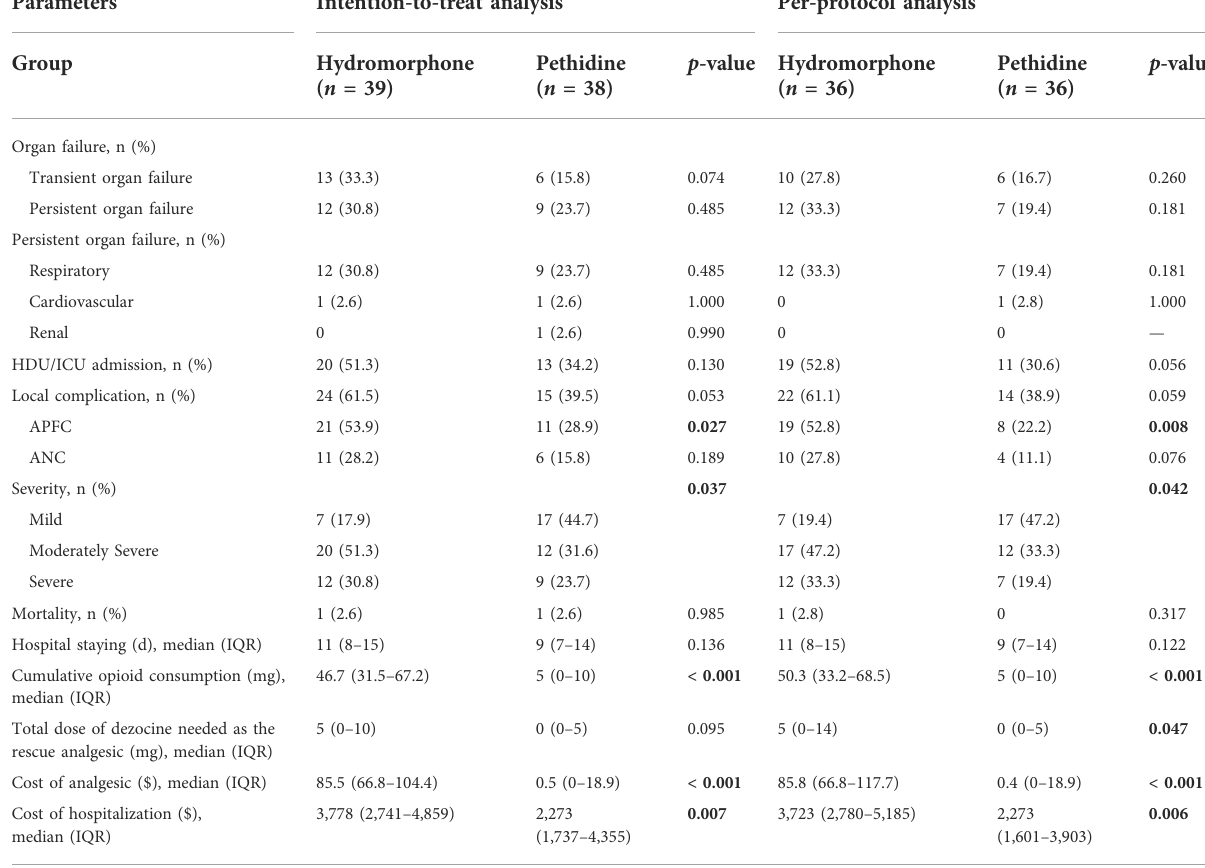
TABLE 3 Secondary outcomes of the two groups based on intention-to-treat and per-protocol analyses.